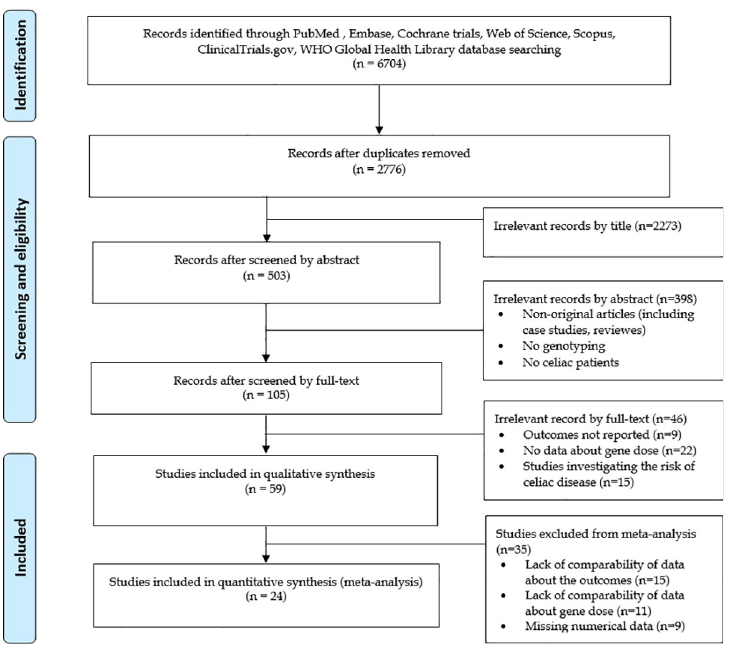
Fig 1. Flow chart of